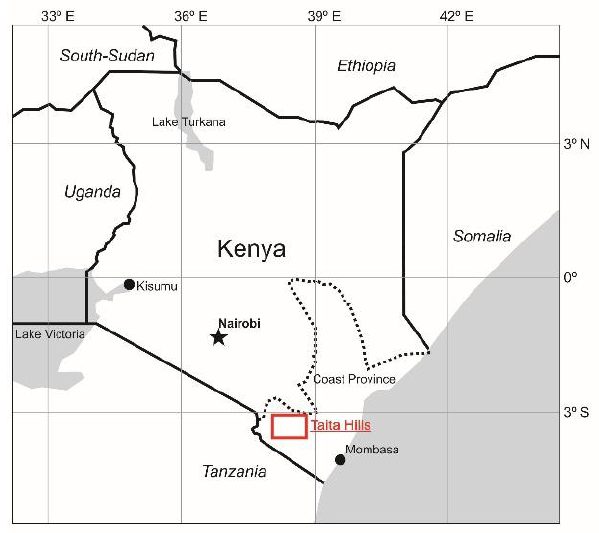
Figure 1. Location of the Taita Hills in south-eastern